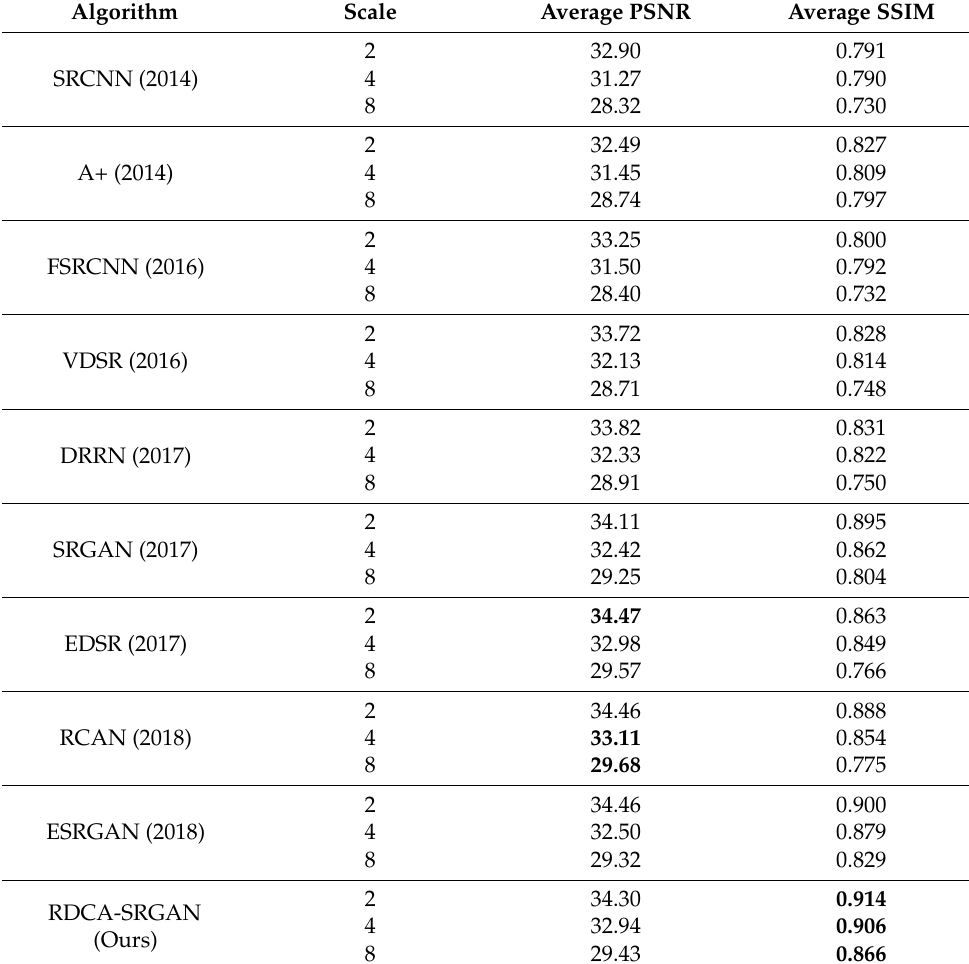
Table 2. Comparisons of PSNR and SSIM from SRCNN, A+, FSRCNN, VDSR, DRRN, SRGAN, EDSR, RCAN, ESRGAN, and